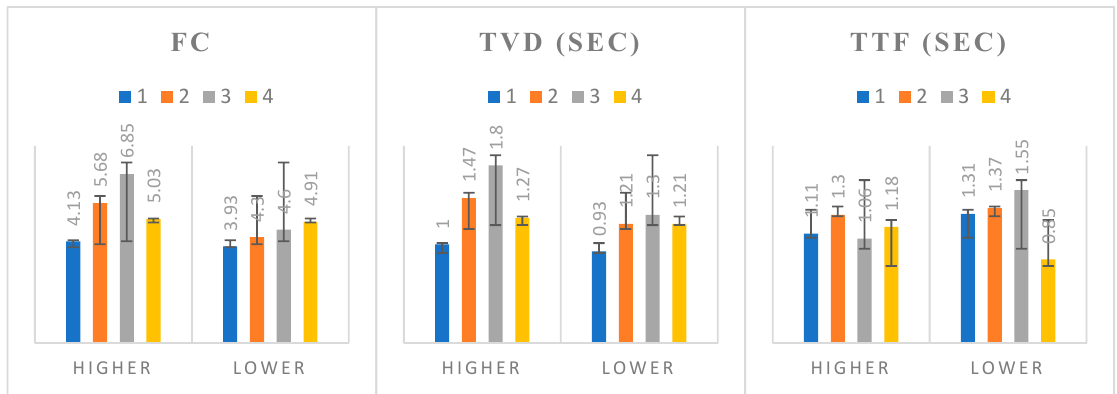
Figure 5. Distribution of the FC, TVD, and TTF by layouts in the two promotion groups.